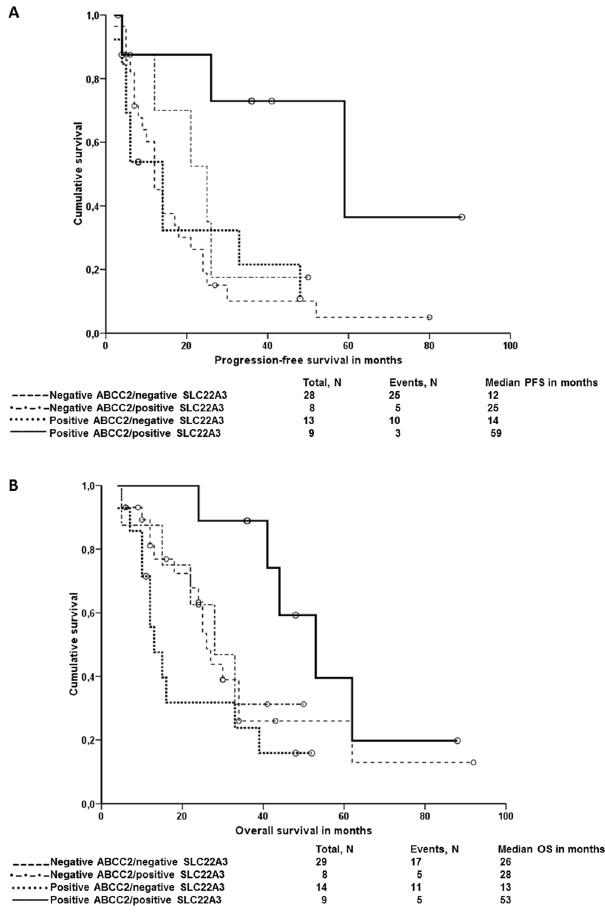
Figure 3. Survival analysis of combinations of SLC22A3 and ABCC2 brush border staining in all patients. Kaplan-Meier survival curves were plotted for the PFS or the OS of patients divided into ABCC2-negative/ SLC22A3-negative (dashed lines), ABCC2-negative/SLC22A3-positive (hatched lines), ABCC2-positive/ SLC22A3-negative (dotted lines), and ABCC2-positive/SLC22A3-positive (solid lines). Plot ( A ) shows results of PFS analysis and plot ( B ) of OS